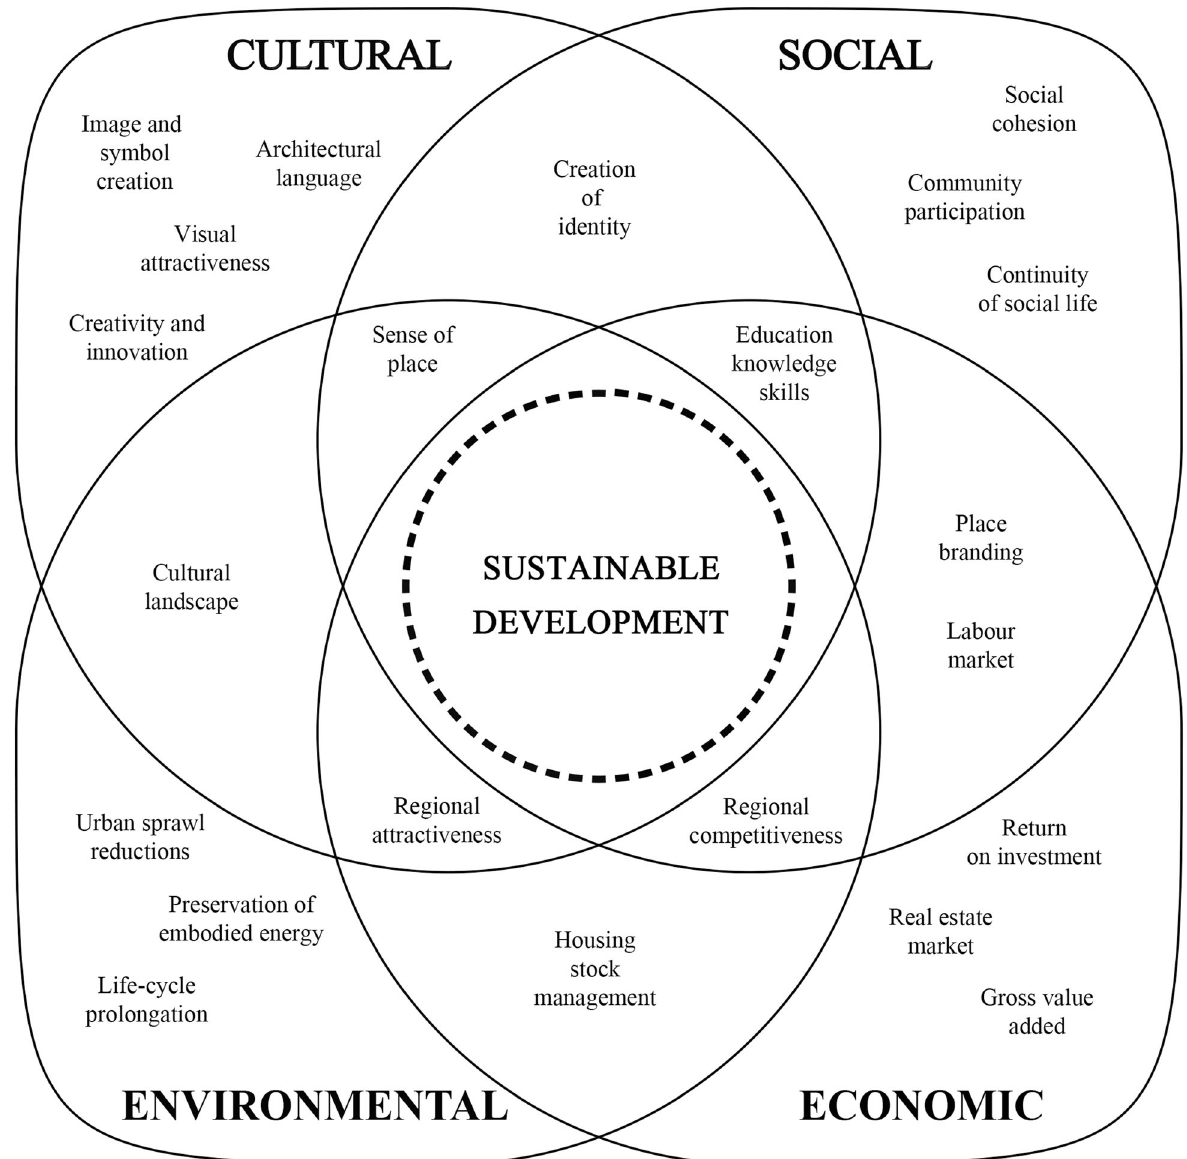
Fig. 7 The holistic four-domain approach diagram. (Source: Europa Nostra 2015; Redrawn by the author